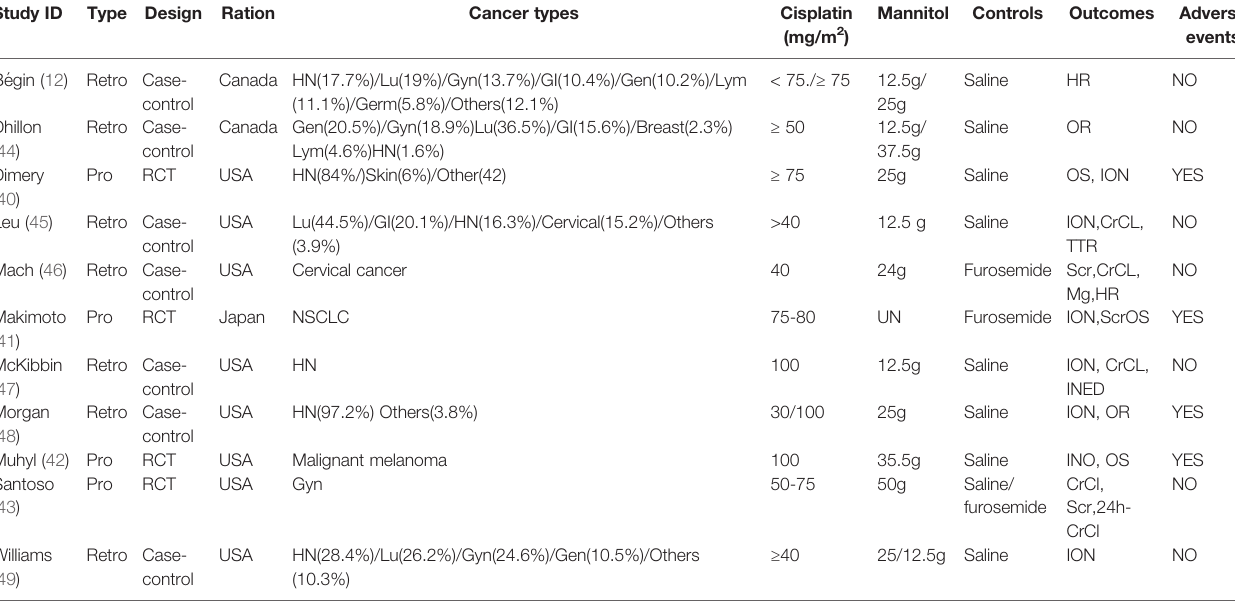
TABLE 1 | Basic characteristics of the included